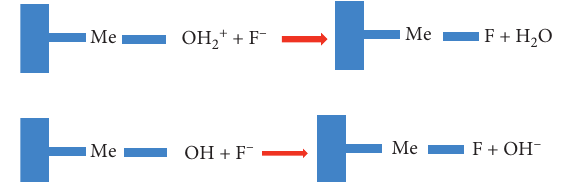
Figure 8: Adopted mechanism for fluoride adsorption ( -adsorbent; Me, multivalent metallic cation)